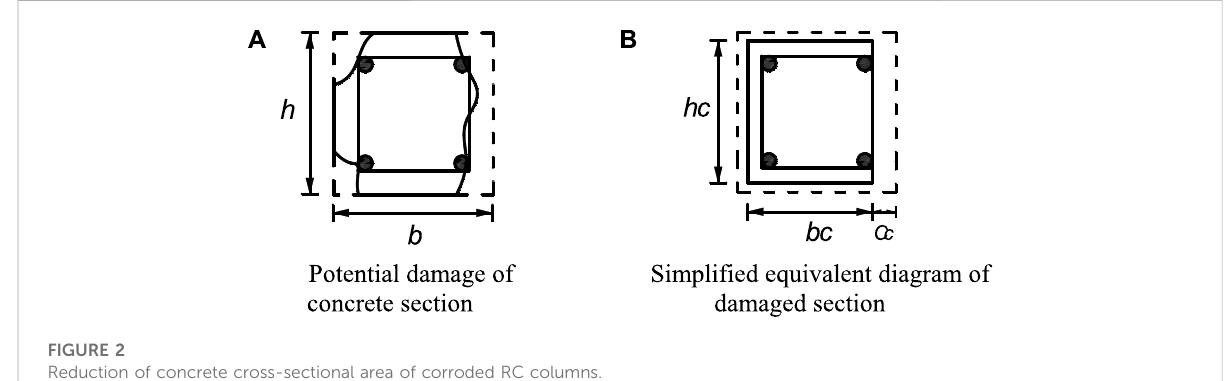
FIGURE 2 Reduction of concrete cross-sectional area of corroded RC